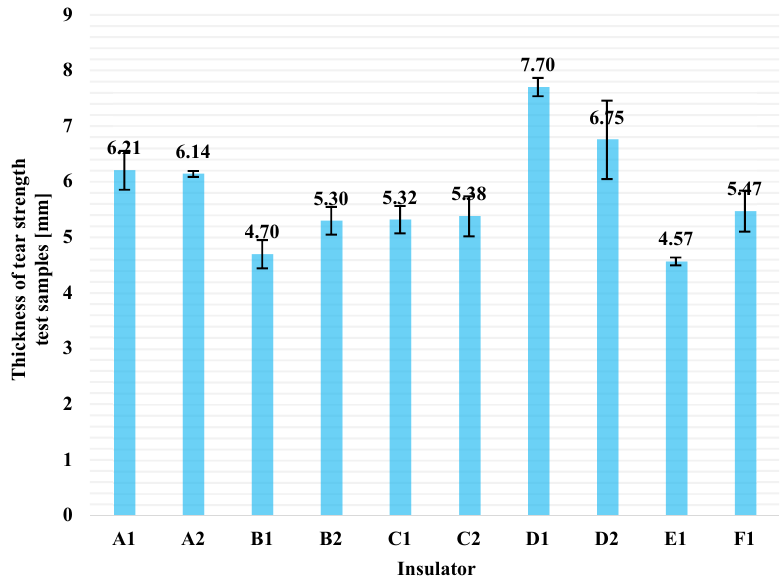
Figure 9. Average thickness values of each pack of five samples (columns) and the corresponding standard deviations (error bars) used for tear strength test.